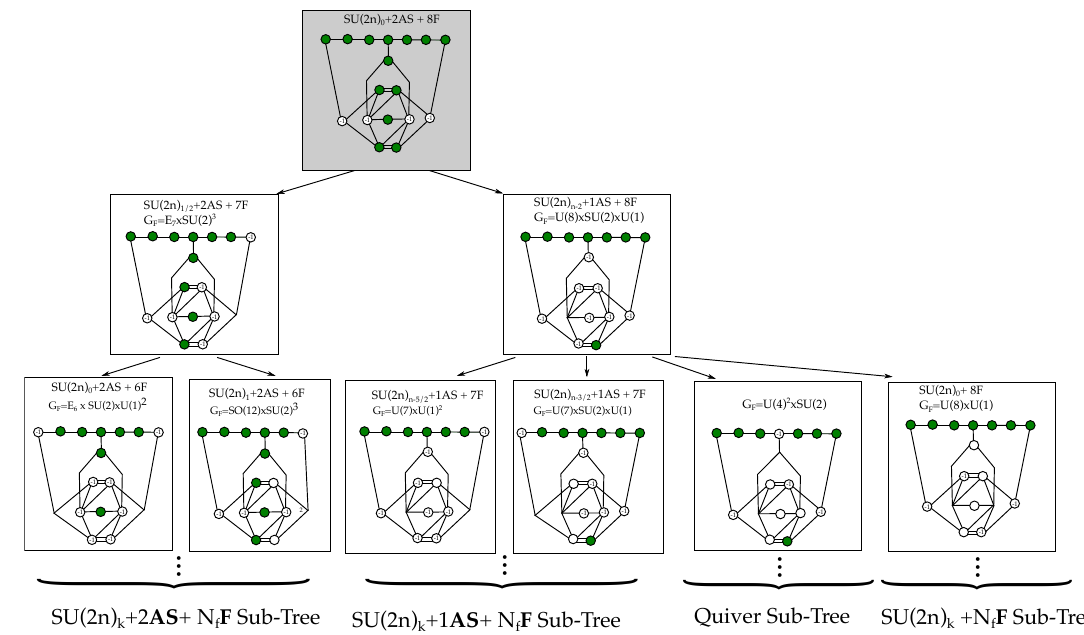
Figure 19. CFD-tree consistent with the decoupling of antisymmetric (cid:13)avors of SU(2 n ) 0 +2 AS + 8 F . On the l.h.s. , the decoupling of fundamental (cid:13)avors results in the sub-tree shown in (cid:12)gure 18. The mass deformations removing the anti-symmetric representations is consistent with the enhance- ment of (cid:13)avor symmetries. The models with 1 AS are consistent with the gauge theory description in tables 8 and